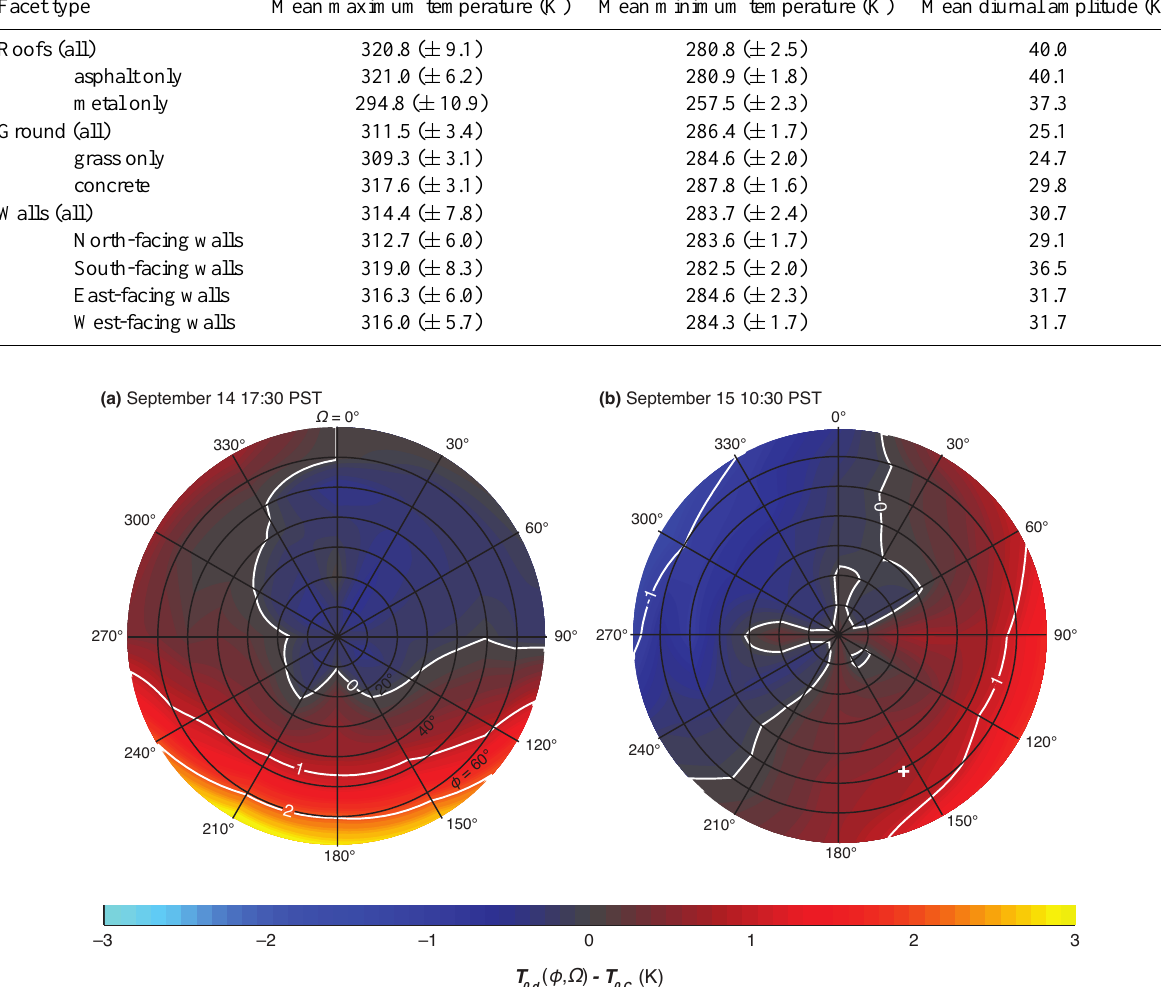
Figure 8. Examples of the bias T 0 , d – T 0 , C for sensors with a narrow FOV in the nadir and various oblique angles 1 hour after sunset (left, 17:30) and in the late morning (right, 10:30). The white cross shows the relative position of the solar disk at this time. Graphs for all other hourly time steps can be found in the Supplement to this